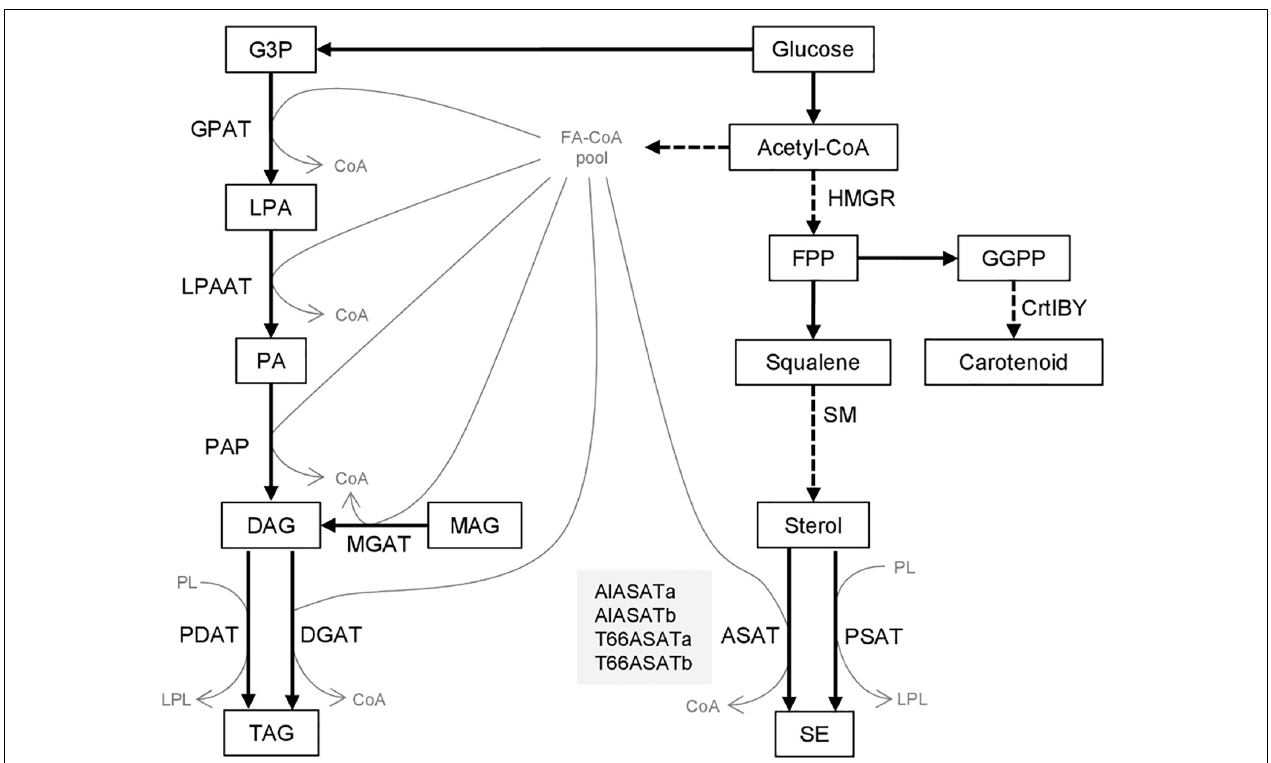
FIGURE 1 | Biosynthesis of triacylglycerol and steryl esters from glucose. Compounds are shown as boxes or thin gray letters, enzymes by the arrows. Dashed arrows denote pathways where more than one enzymatic step are involved. The four proteins discussed in this paper are shown in the gray box. G3P, Glycerol-3-phosphate; LPA, lysophosphatidic acid; PA, phosphatidic acid; DAG, diacylglycerol; MAG, monoacylglycerol; TAG, triacylglycerol; PL, phospholipid; LPL, lysophospholipid; FA-CoA, Fatty-acyl-CoA; FPP, farnesyl pyrophosphate; GGPP, geranylgeranyl pyrophosphate; SE, steryl ester. GPAT, acyl-CoA:sn-glycerol-3-phosphate acyltransferase; LPAAT, acyl-CoA:lysophosphatidic acid acyltransferase; PAP, phosphatidic acid phosphatase; MGAT, acyl-CoA:monoacylglycerol acyltransferase; PDAT, phospholipid:diacylglycerol acyltransferase; DGAT, acyl-CoA:diacylglycerol acyltransferase; HMGR, β -Hydroxy β -methylglutaryl-CoA reductase; SM, squalene mono-oxygenase; ASAT, acyl-CoA:sterol acyltransferase; PSAT, phospholipid:sterol acyltransferase; CrtIBY, a trifunctional protein with phytoene desaturase; geranylgeranyl phytoene synthase and lycopene cyclase activities.